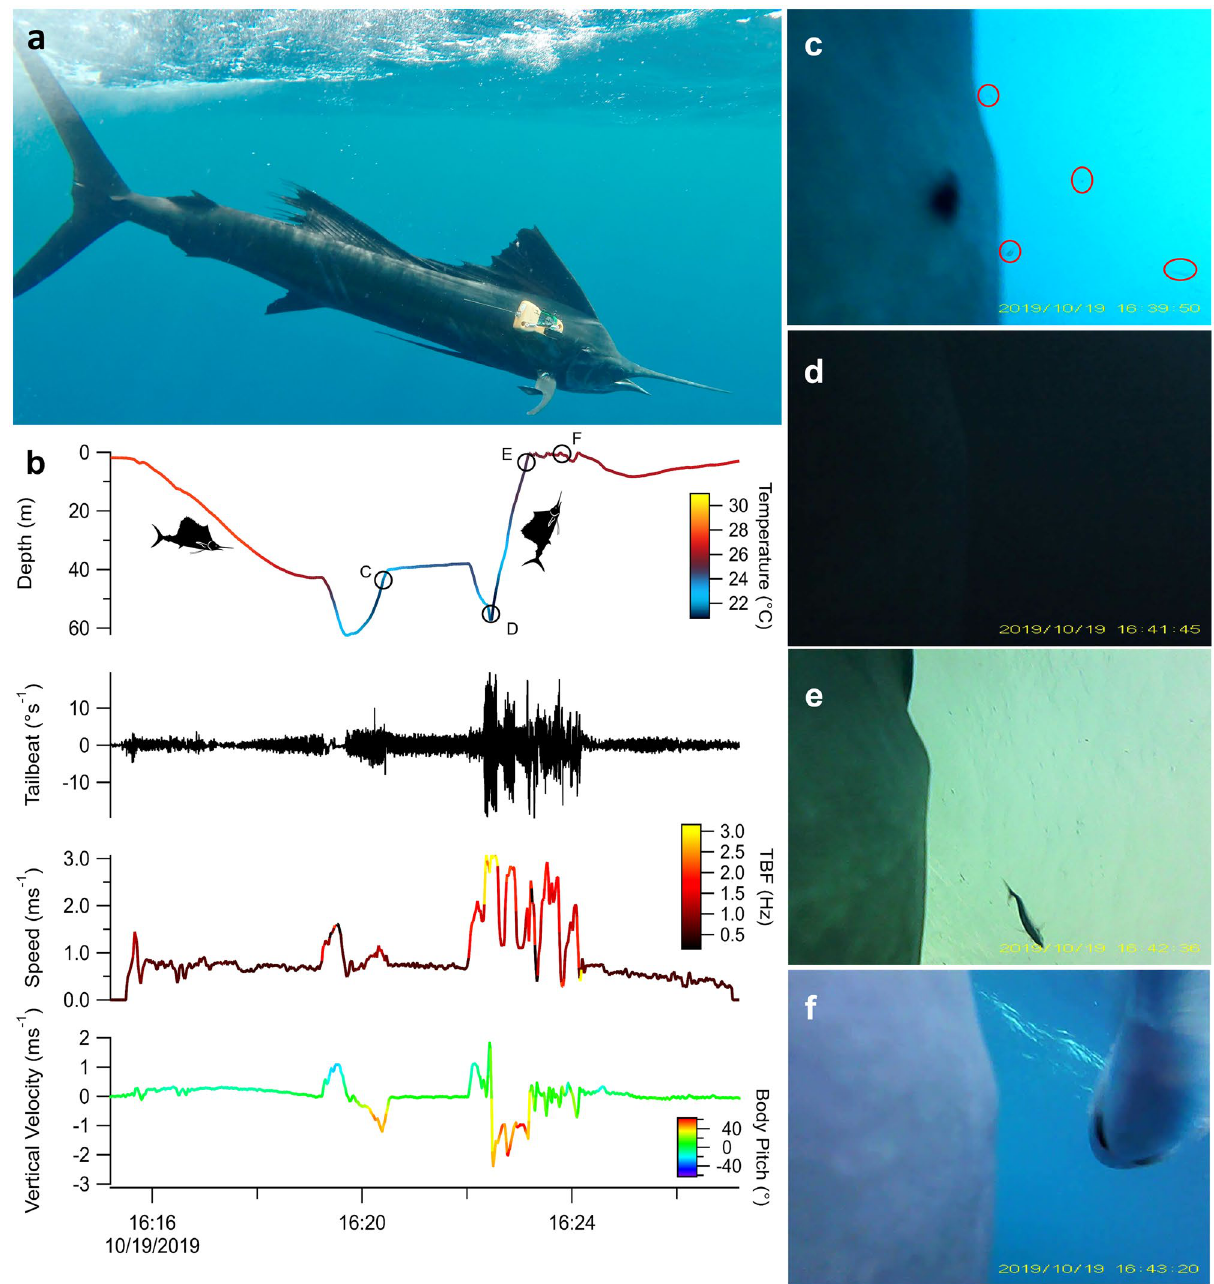
Figure 2. Sailfish activity before, during and after the predation event. ( a ) Biologging float package attached to sailfish. ( b ) Depth, temperature, tailbeats (°sec −1 ), speed (ms −1 ), tailbeat frequency (TBF; Hz), vertical velocity (ms −1 ) and body pitch angle (°) of the dive in which the event occurred. The timing and depth associated with each image ( c – f ) are identified by circles on the depth profile in ( b ). ( c ) The sailfish ascends from 60 m and encounters multiple potential prey items, outlined in red. ( d ) The available light is notably low at this depth and decreases rapidly with depth to almost zero light. ( e ) First observation of the prey. ( f ) Prey possibly attempting to ‘hide’ from the sailfish by swimming very close to it during the